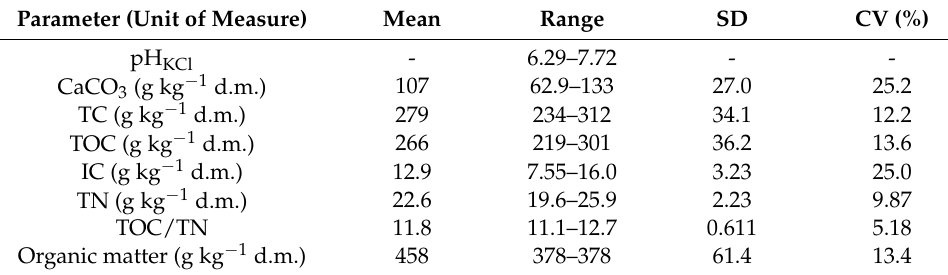
Table 3. Selected chemical properties of spent mushroom substrates. Parameter (Unit of